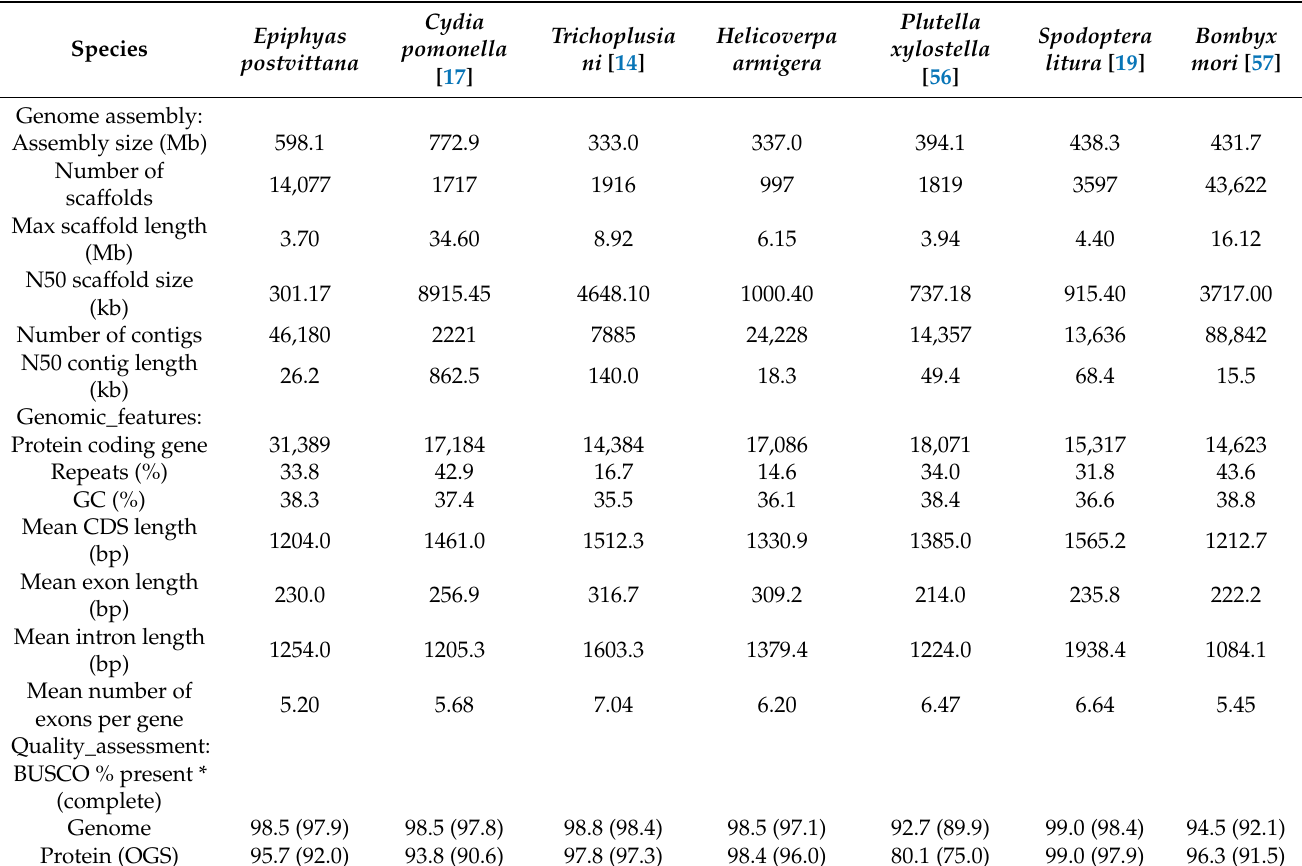
Table 1. Summary statistics of the assembly, features and quality assessment of the Epiphyas postvittana genome in comparison with those of other lepidopteran species.